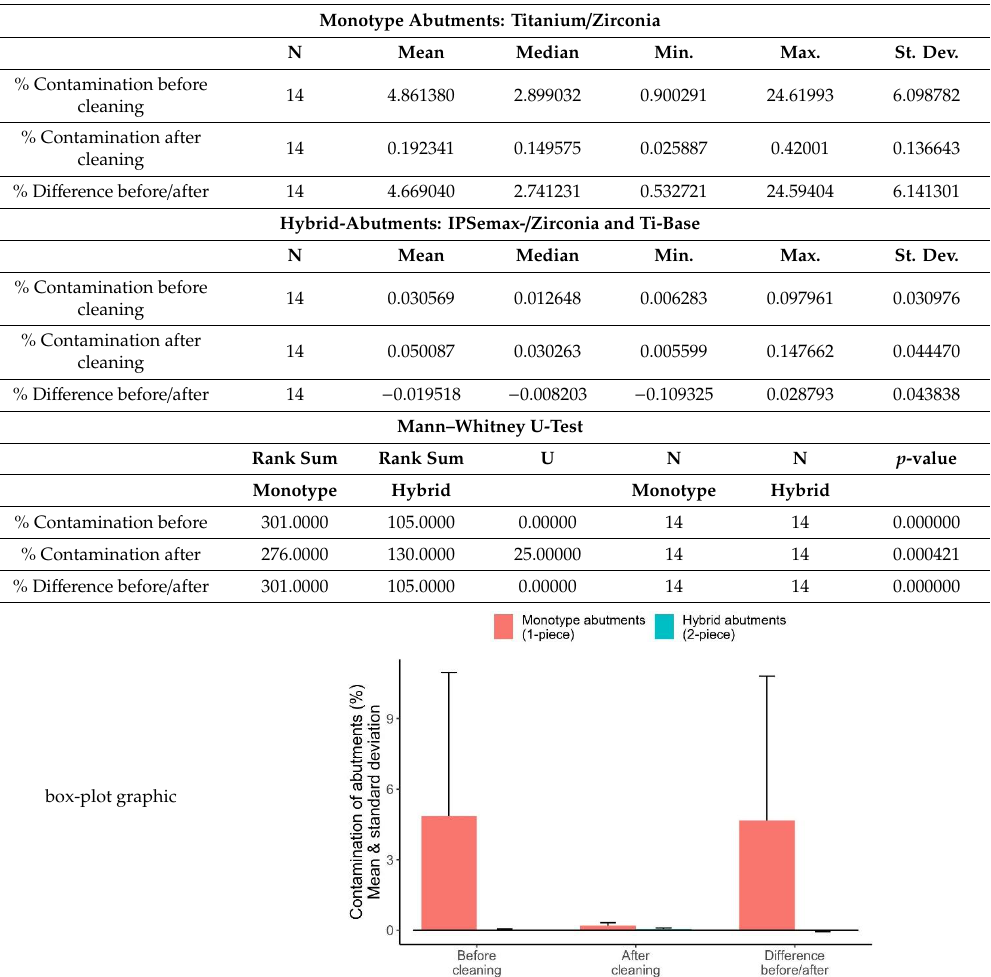
Table 7. Comparison of projected surface contamination between monotype and hybrid abutments before and after cleaning in percent; Mann – Whitney U-Test; box-plot graphic.